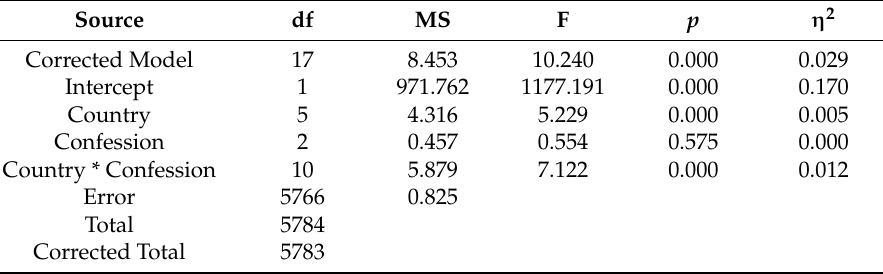
Table A17. Country and confession on accepting/giving a